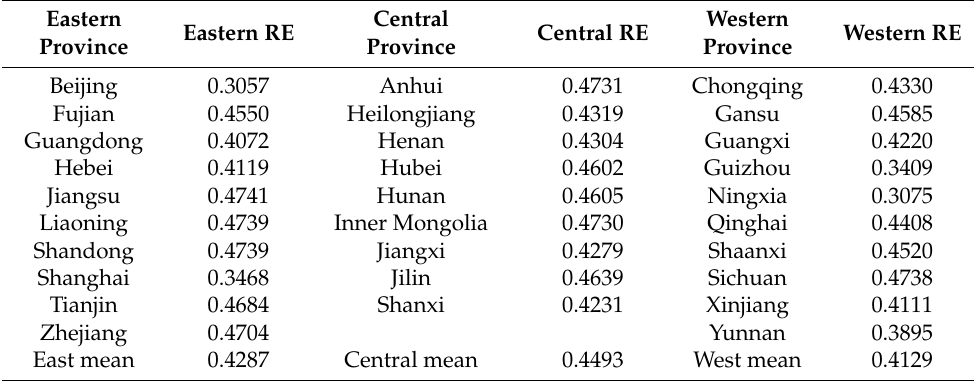
Table 6. The average energy rebound effect from 2000 to